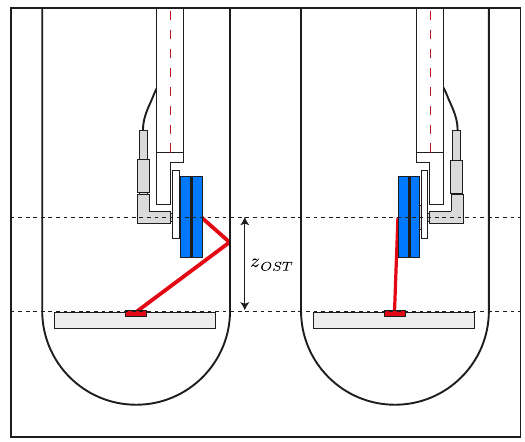
are shown the shortest distances for the Second Sound to reach the OSTwith and without reflection. The heat source is plotted in scale.